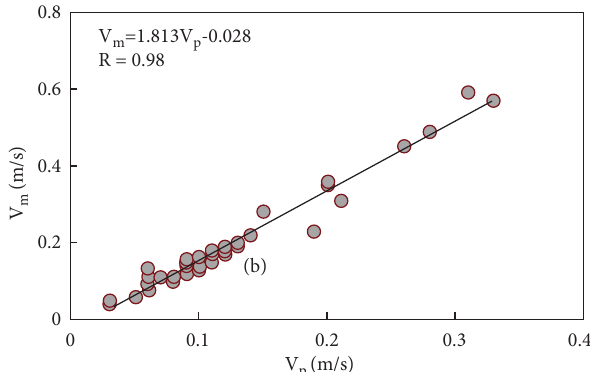
Figure 8: The correlation between the peak velocity and the average velocity.